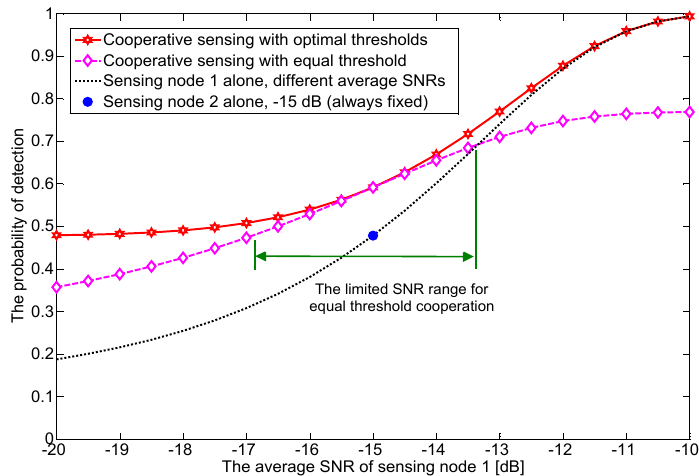
Figure 3. The detection performance for a single and two cooperative sensing cases when the average SNR of the sensing node 1 varies from − 20 dB to − 10 dB and that of the sensing node 2 is fixed at − 15 dB. We notice that the effective range of the average SNR is very limited for the equal threshold